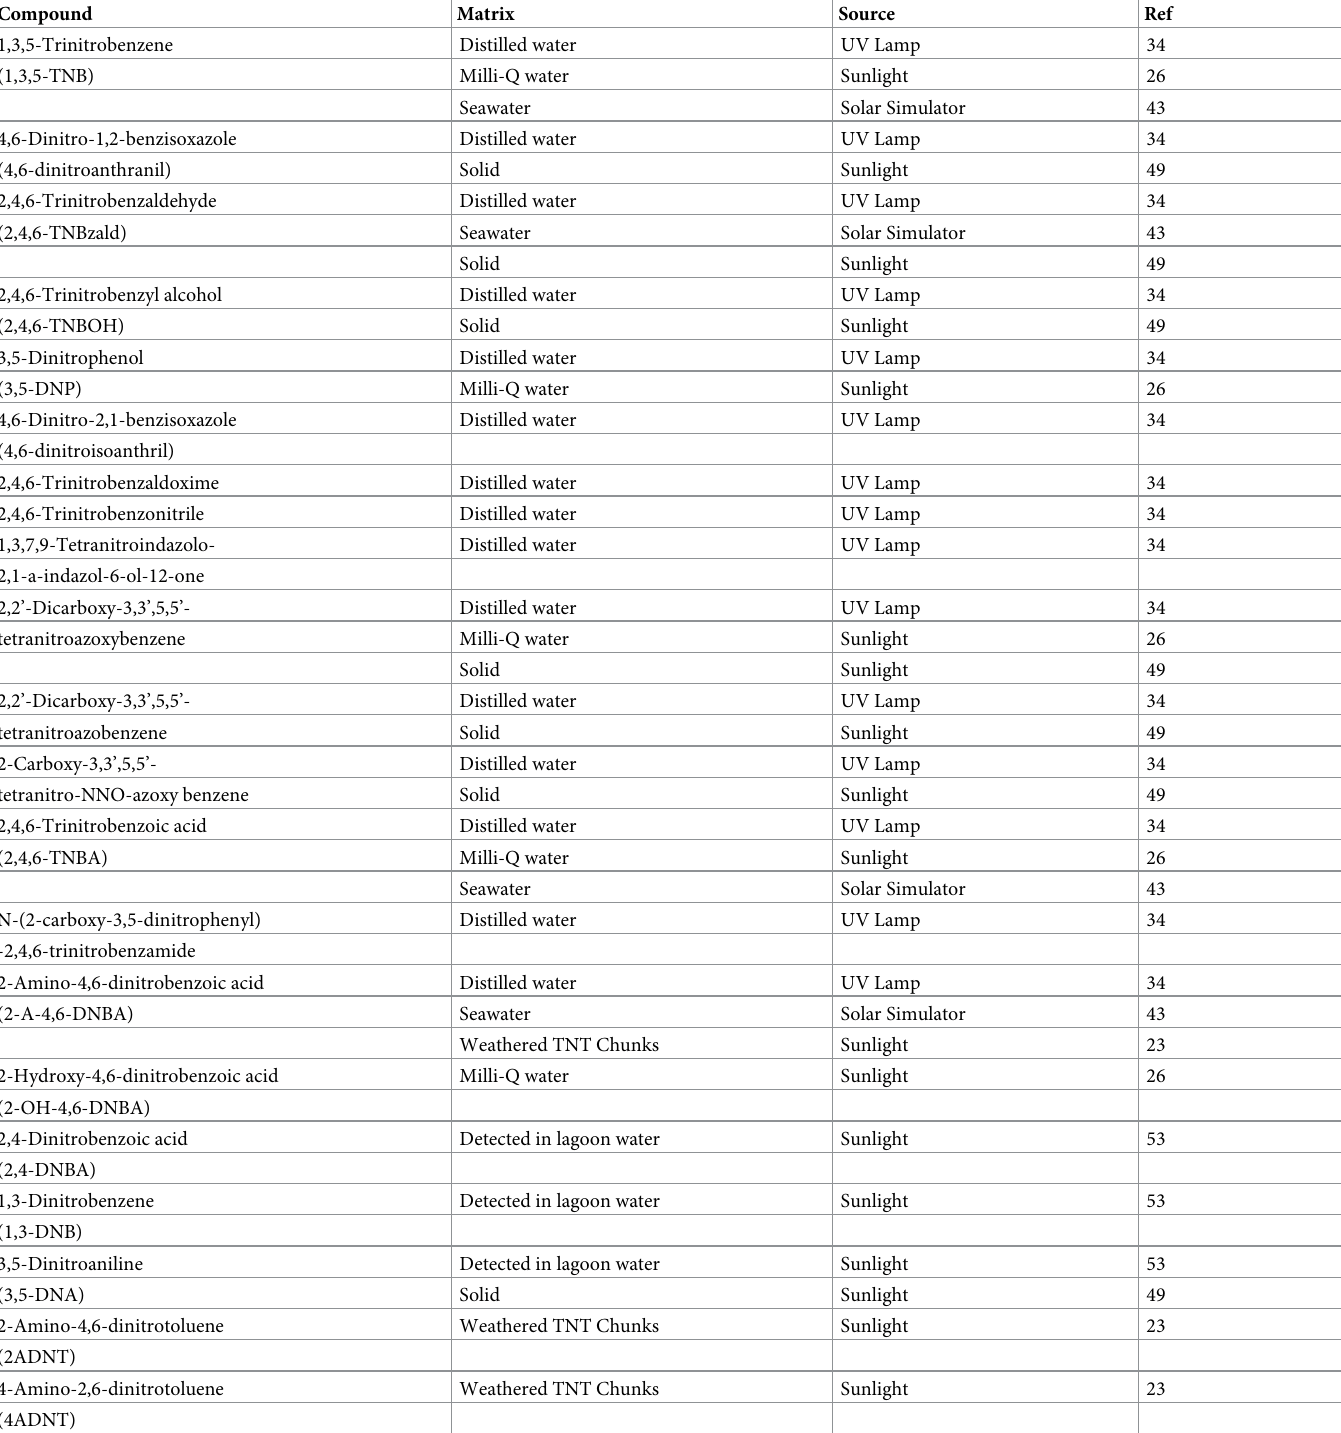
Table 1. Reported photodegradation products of